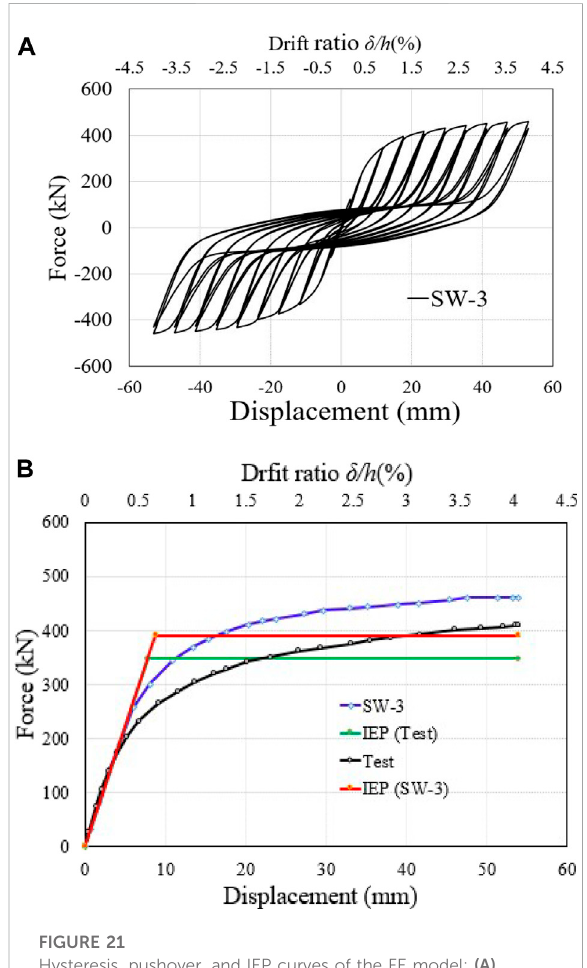
FIGURE 21 Hysteresis, pushover, and IEP curves of the FE model: (A) Hysteresis, (B) pushover, and IEP curves.